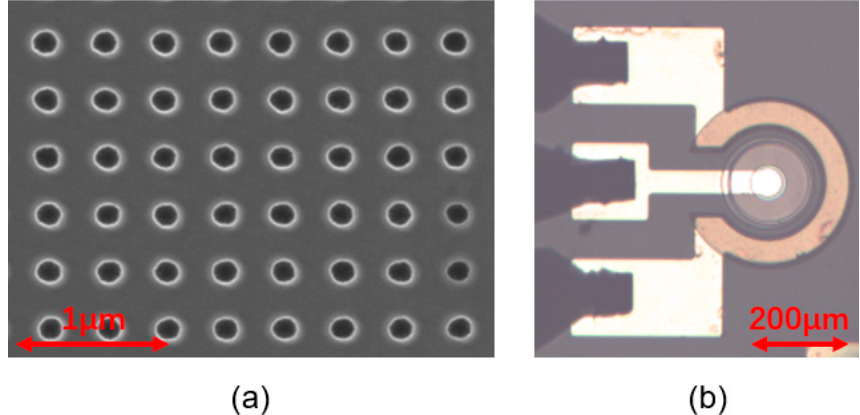
Figure 5. ( a ) The scanning electron microscopy (SEM) images of the hole-patterned photonic crystal structure. ( b ) Top view of PC90 LED chip with mesa radius of 90